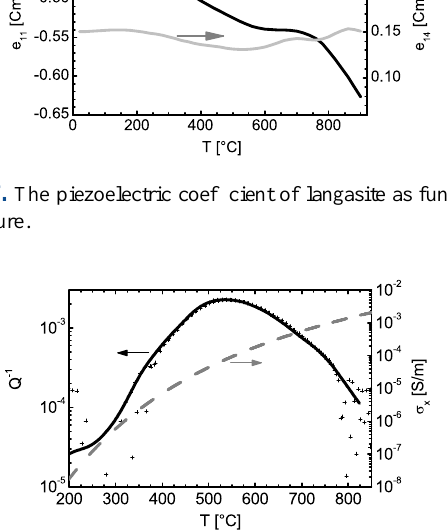
Figure 8. The inverse resonant quality factor Q − 1 and the elec- tric conductivity σ X of langasite rod operated at 220kHz in length extensional mode of